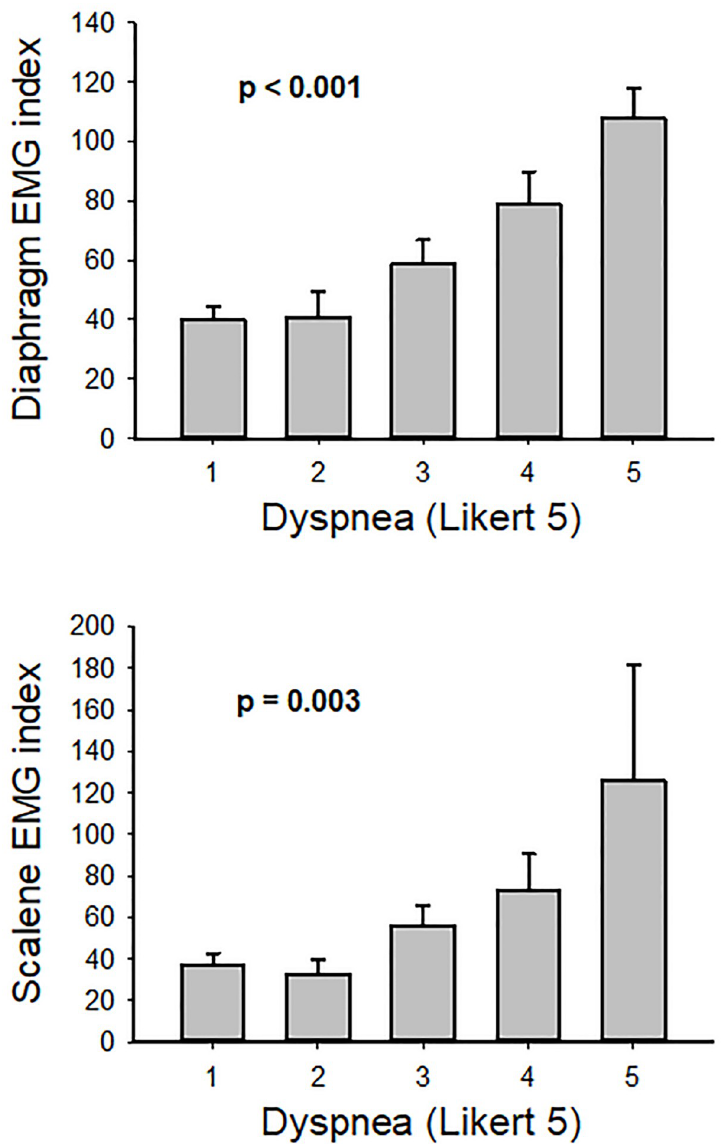
Fig 3. Diaphragm and scalene EMG activity index as a function of dyspnea (Likert 5 scale). EMG indices increased with dyspnea severity. Data are EMG index for measurements (all patients, all days) with a given dyspnea index value. Data are mean ± SE. See text for more